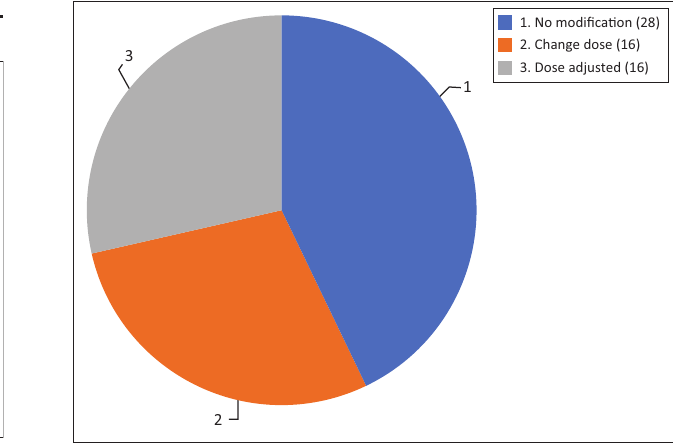
FIGURE 2: Distribution of patients according to chemotherapy treatment modification ( n = 58).